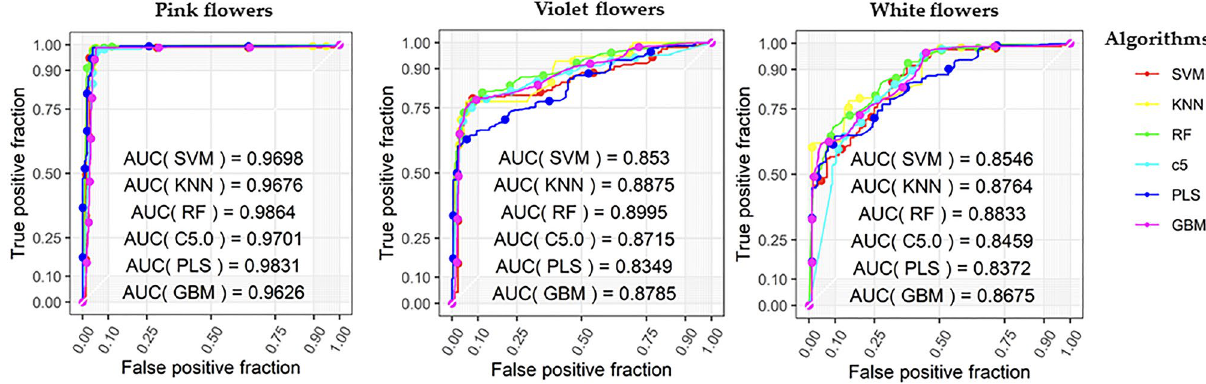
Figure 2. Machine learning model for flower color prediction accuracy in P. grandiflorus . Receiver operating characteristic (ROC) curves for 9 SNPs (FDR < 0.05) using six machine learning models. Each values of area under the curve (AUC) shows the average of 10 cross validations for pink, violet, and white flowers. The six models used are support vector machine (SVM), k -neural network ( k -NN), random forest (RF), C5.0 decision tree (C5.0), partial least square (PLS), and gradient boosting